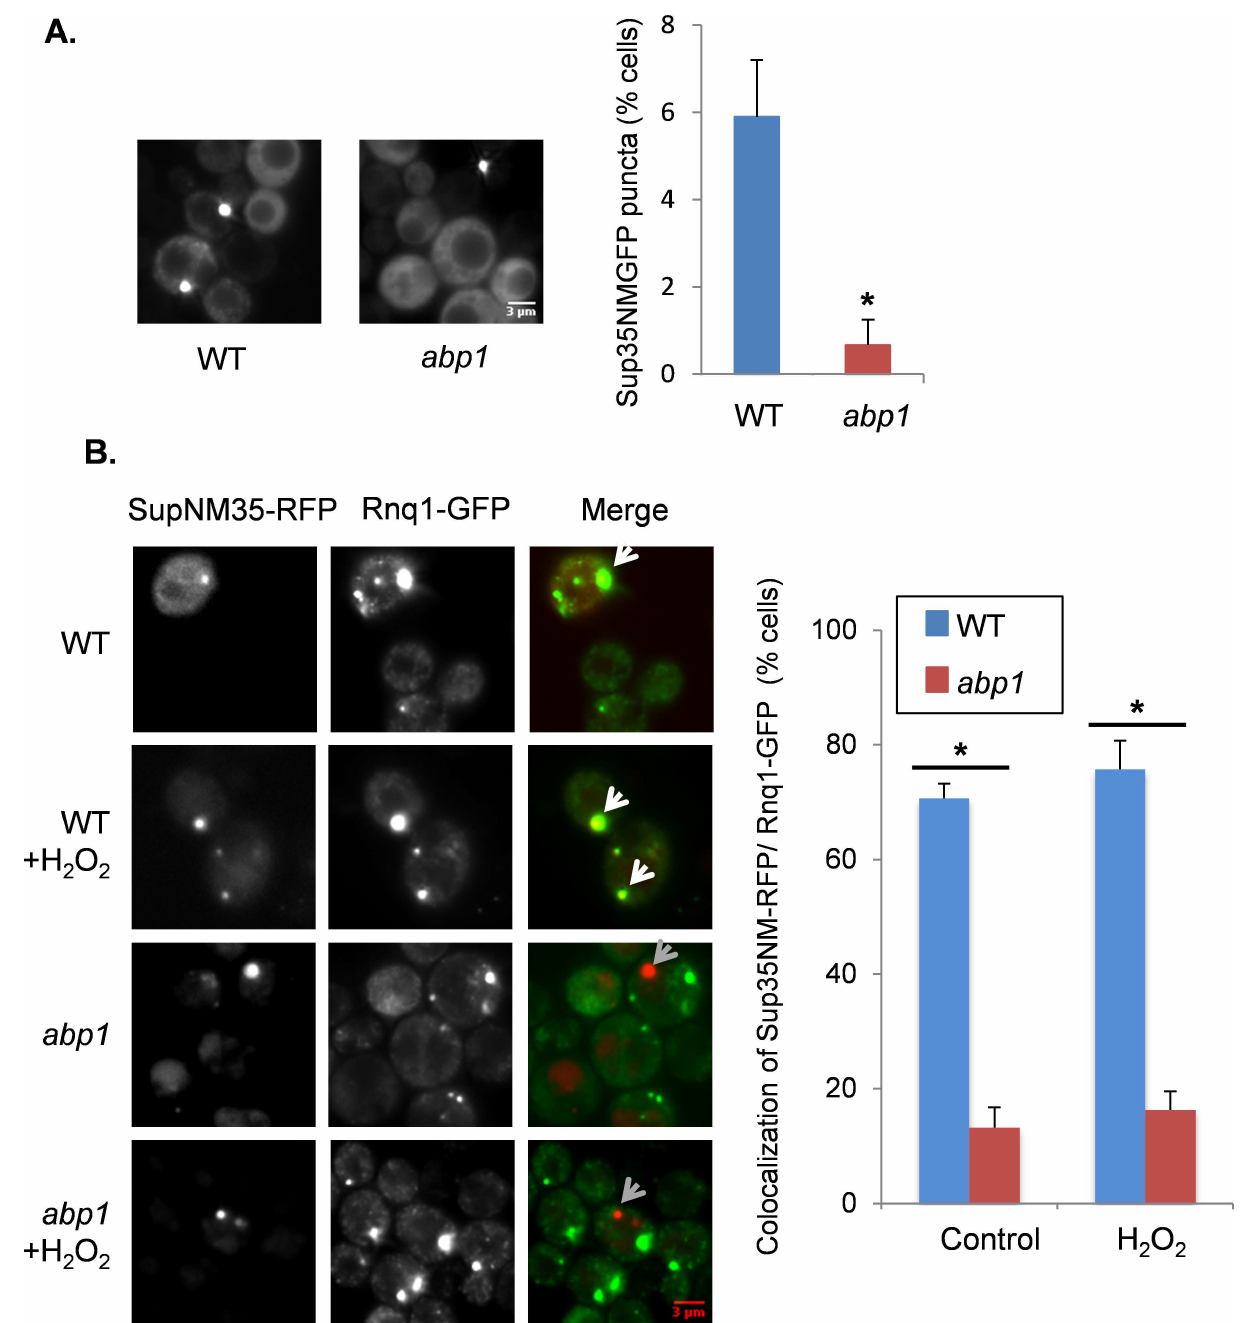
Fig 6. Loss of ABP1 reduces the co-localization of Sup35 with Rnq1 aggregates. A. Fluorescence micrographs are shown for the wild- type and abp1 mutant strain treated with 100 μ M hydrogen peroxidefor 20 hours. Sup35-NMGFP was inducedwith copperfor 2 hours to visualizeaggregateformation and the frequencyis shown as the percentageof cells containing visible Sup35 foci from approximately 1000 cells counted. Error bars denote standard deviation; * marks statistical significanceat p < 0.01. B. The wild-typeand abp1 mutant strains containingSup35NM-RFP and Rnq1-GFP were grown for 20 hours in SRaff media in the presenceor absenceof 100 μ Mhydrogenperoxide before switchingto SGal media for three hours to induce the expressionof Sup35NM-RFP and Rnq1-GFP. White arrows show examples where Sup35NM-RFP and Rnq1-GFP co-localize, whereas,grey arrows show exampleswhere Sup35NM-RFP does not localize with Rnq1-GFP. The frequency of co-localization of Sup35NM-RFP and Rnq1-GFP is shown as a percentageof co-localization for at least 17 Sup35NM-RFP foci scored in triplicate experiments. * marks statistical significanceat p < 0.01